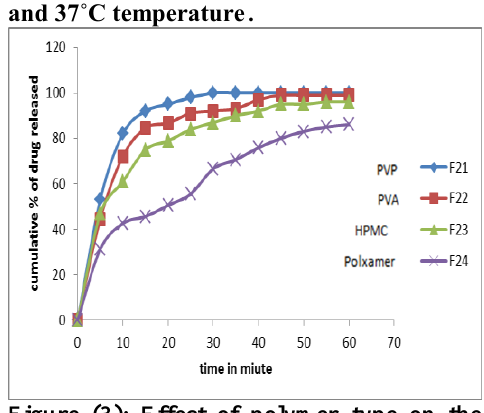
Figure (3): Effect of polymer type on the nanoparticles from F21, F22, F23, and F24 in 0.1 N HCL solutions (pH 1.2) containing 2% brij-35 w/v at 50 r.p.m and 37˚C